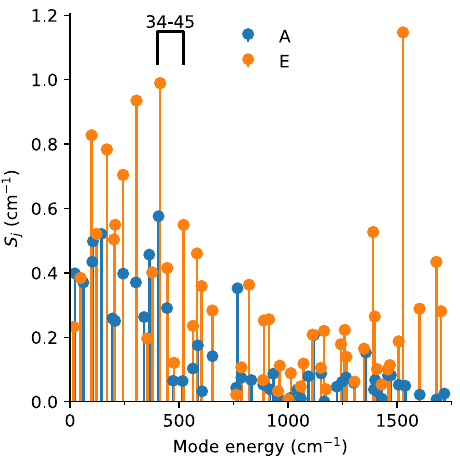
Fig. 6 Ab initio calculated vibronic coupling strength. S j of the vibrational modes of 1 opt with A (blue) and E (orange) symmetry. Modes 34 – 45 are